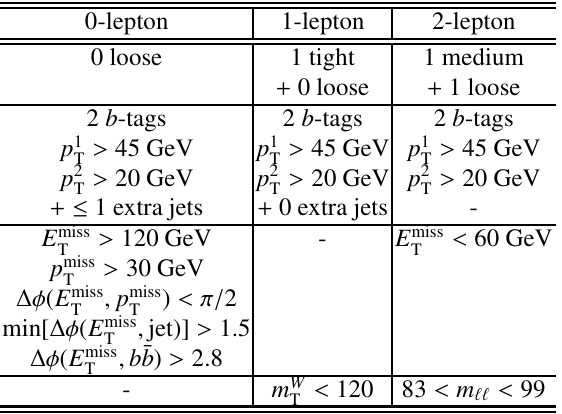
Table 1. The basic event selection of the three channels [9].